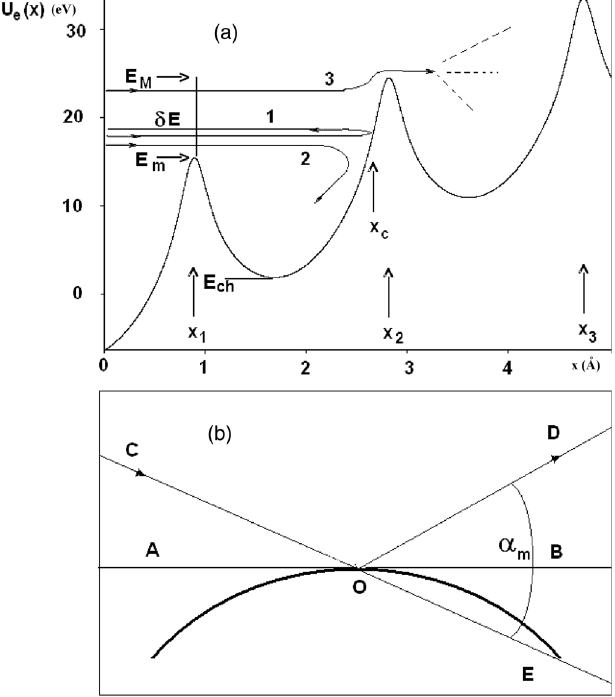
FIG. 1. Scheme of volume reflection and volume capture processes: (a) the effective potential of bent crystallographic planes, x is the transverse coordinate. E M and E m are the transverse energies corresponding to neighboring local maxima of the potential; E is one of the transverse energies correspond- ch ing to a local minimum of potential; x 1 ; x 2 ; x 3 are the transverse coordinates of the local maxima; the curves 1,2,3 reflect the different possibilities for moving particles. x c is the critical coordinate for volume reflected particles; (b) geometric relations of the process. For additional information, see the